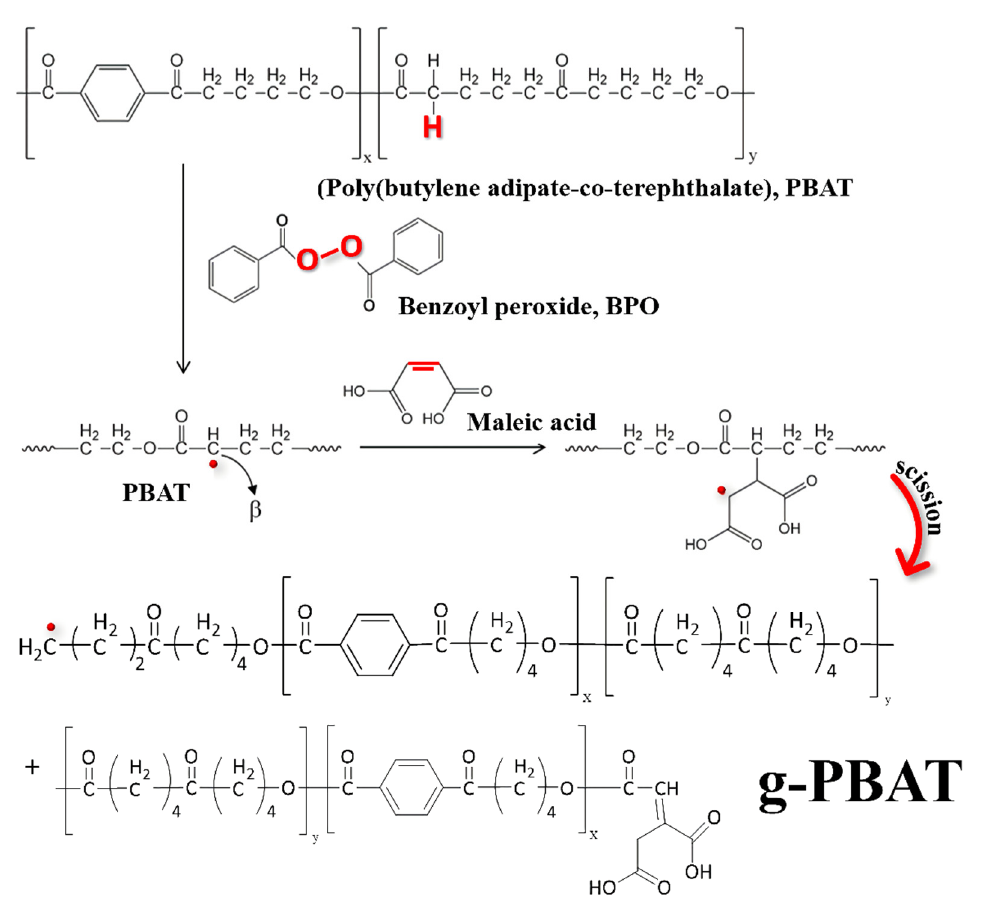
Figure 4. The possible mechanism of the free-radical reactions for the PBAT copolyester.